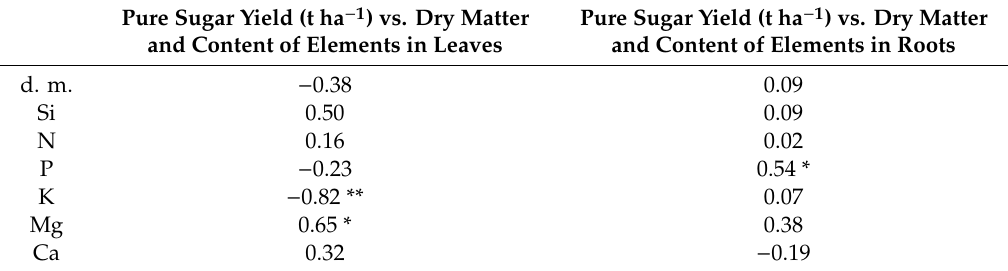
Table 5. Correlation coe ffi cients of pure sugar yield and chemical content of sugar beet plants in 2013 and 2014 ( n =